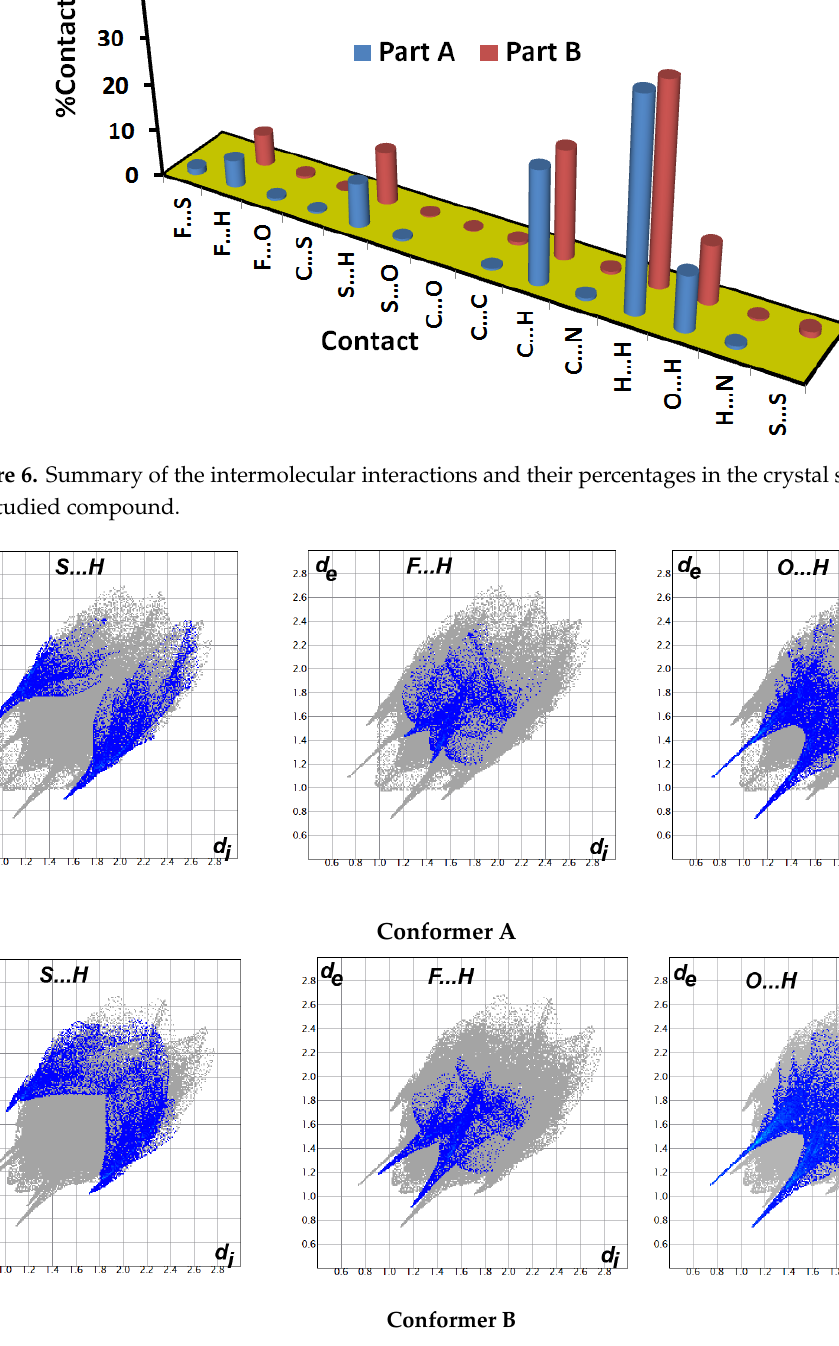
Figure 6. Summary of the intermolecular interactions and their percentages in the crystal structure of the studied compound.